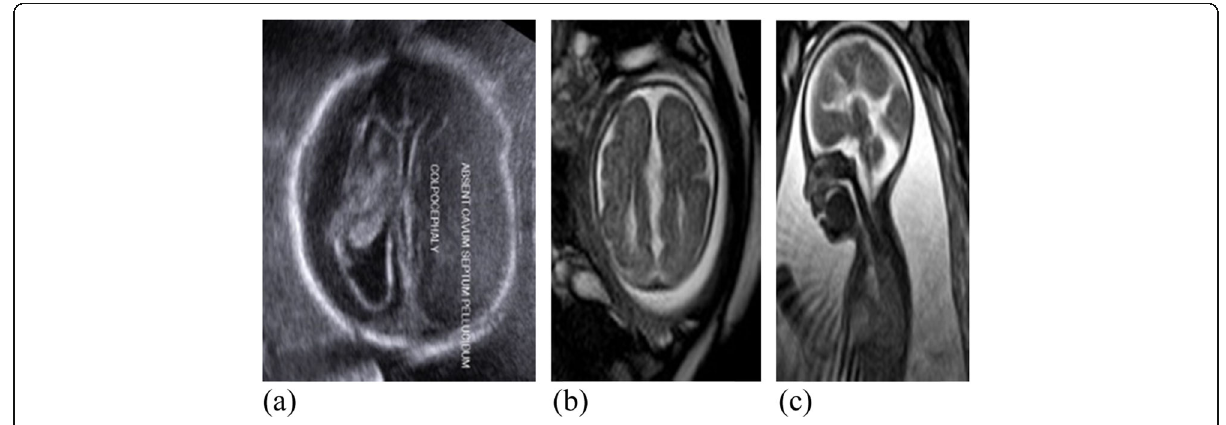
Fig. 3 Twenty-seven-week fetus a US showed absent septum pellucidum and colpocephaly. b , c Axial and sagittal MRI (B-FFE) images showed parallel orientation of the lateral ventricular bodies and confirmed the diagnosis of CC